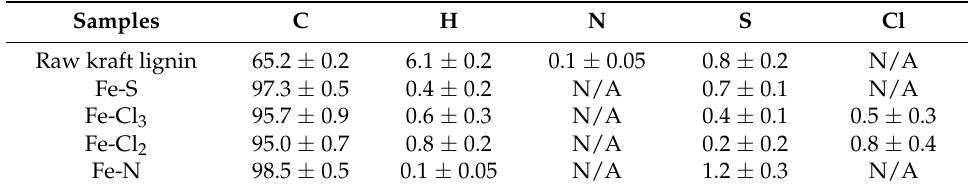
Table 2. Weight percentage values of elemental analyses of raw kraft lignin and thermally